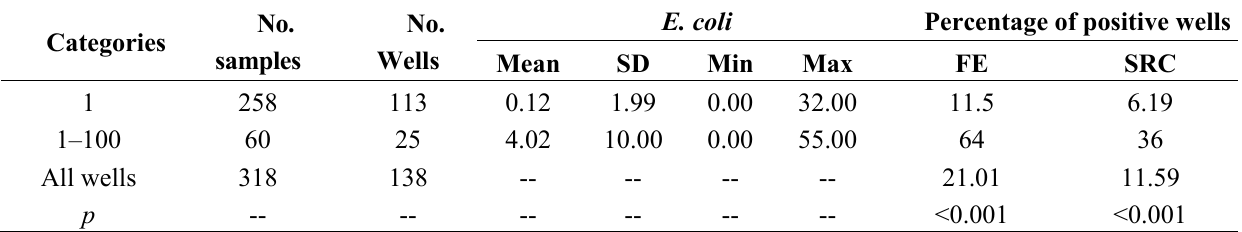
Table 2. Pathogenic bacteria and E. coli according to the risk categories.